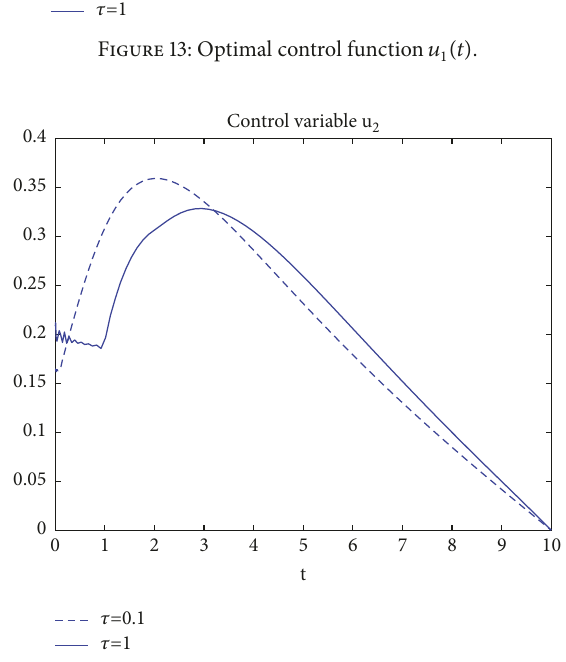
Figure 14: Optimal control function 𝑢 2 (𝑡)